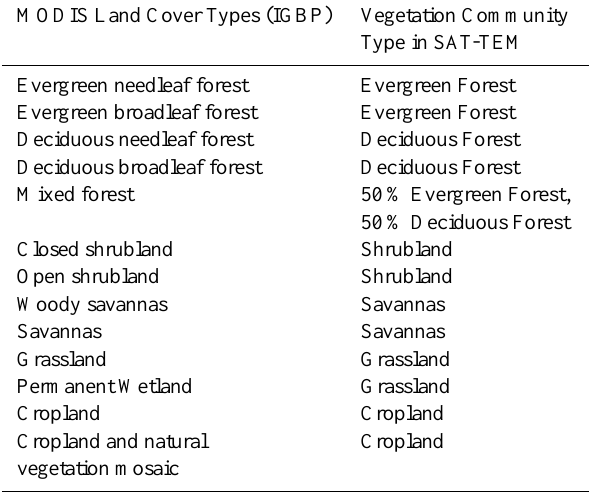
Table 2. Reclassification of MODIS land covers to TEM vegetation